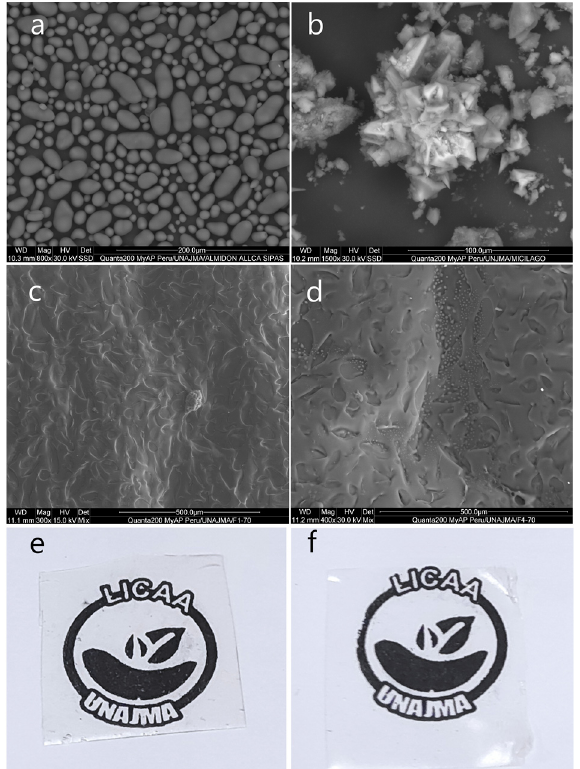
Figure 5. ( a ) SEM image for native potato starch Allcca sipas, ( b ) SEM image for dehydrated nopal mucilage, ( c ) SEM image for F1-70, ( d ) SEM image for F4-70, ( e ) edible film F1-70, ( f ) edible film F4-